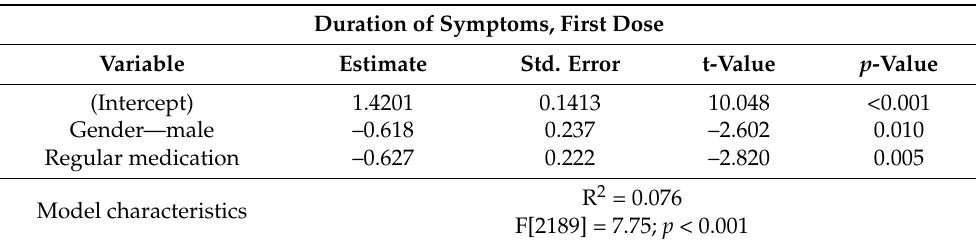
Table 9. Linear model results for duration of symptoms (days) after first dose.